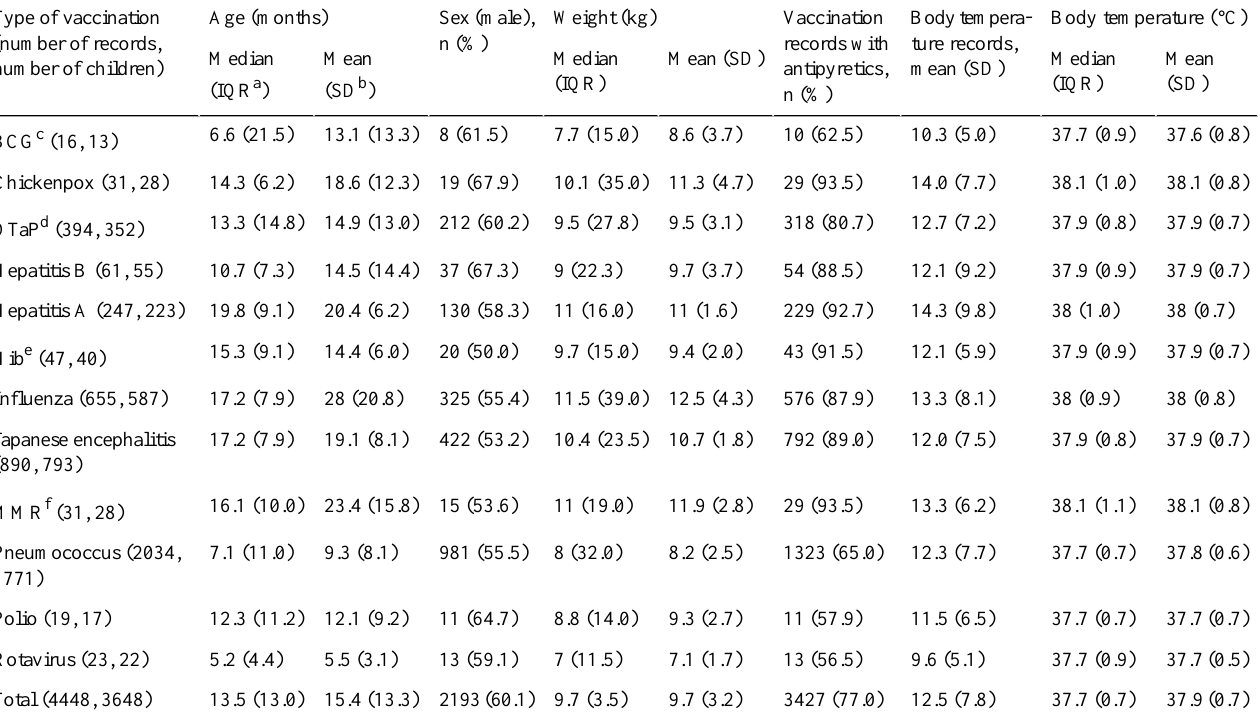
Table 1. Basic characteristics according to vaccine type and the presence of antipyretic drugs.